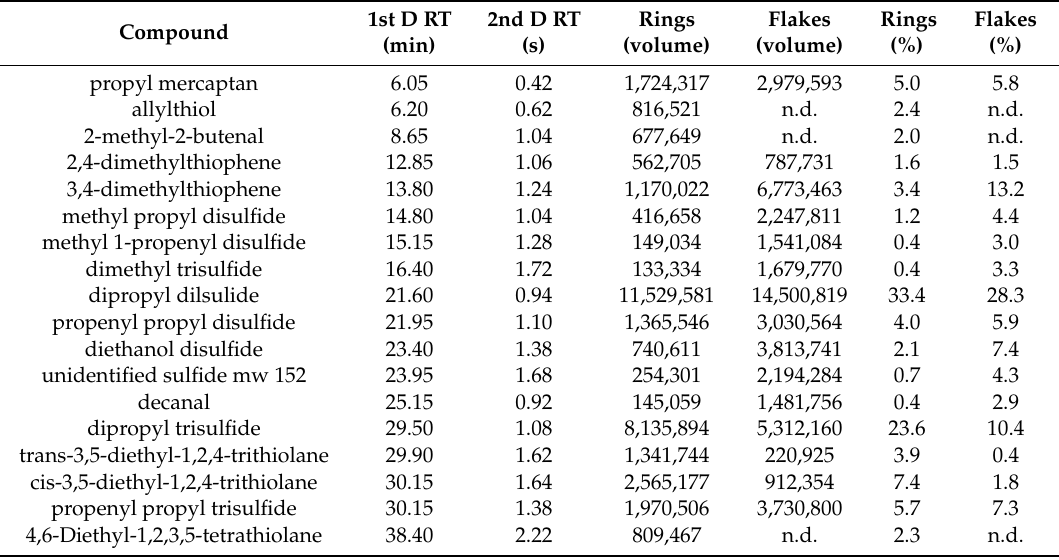
Table 3. Main volatile organic compounds detected by HS-SPME-GC × GC-TOF in the di ff erent onion samples. Data are the mean of three determinations. First dimension retention time in minute (1st D RT). Second dimension retention time in second (2nd D RT). Response of the two-dimensional peak (volume). Relative amount (%) calculations were based on the ratio between the peak volume of each compound and the sum of volumes of all selected compounds. Not detected (n.d.). Compound